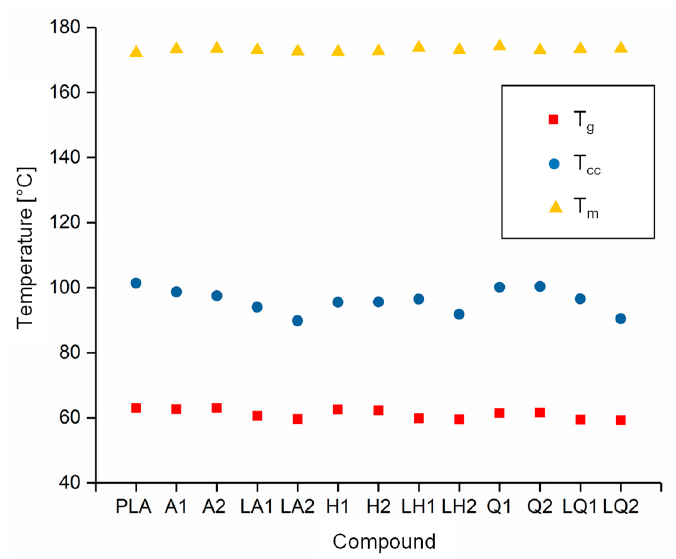
Figure 6. Thermal transition temperature of PLA and the PLA/dye compounds.